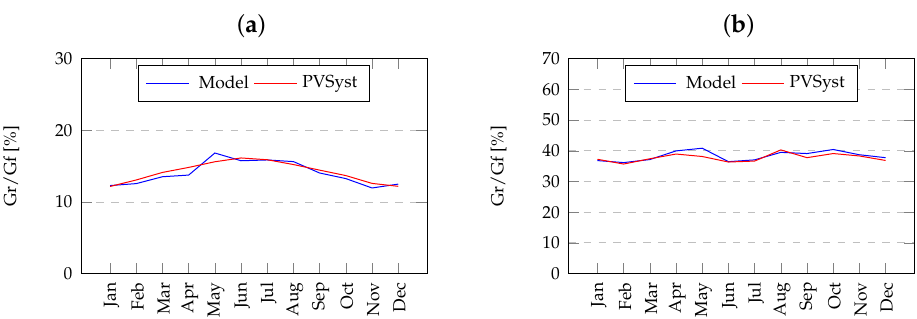
Figure 14. Estimated model comparison vs. the PVSyst Gr/Gf % gain from Jan to Dec for the ( a ) tilted SN orientation and ( b ) vertical EW orientation, Location—Thiruvananthapuram